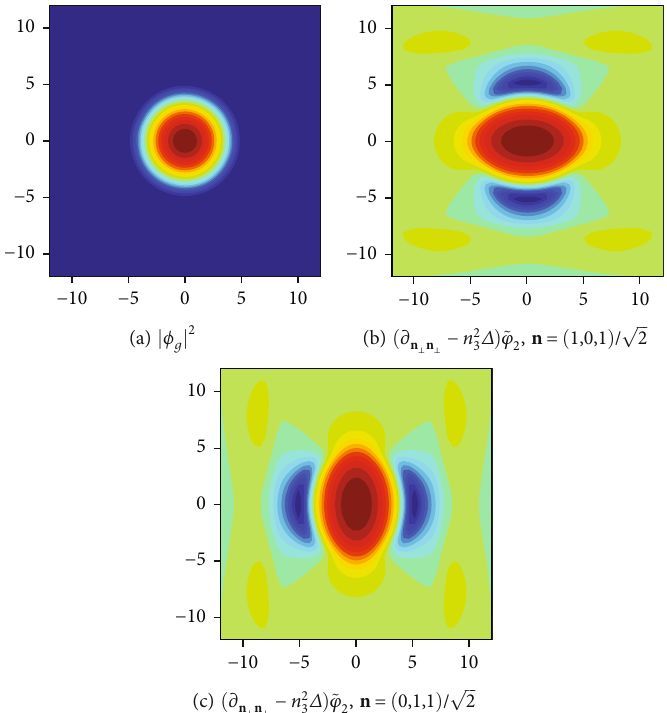
Figure 8: The contour of the density function j ϕ − n 2 Δ Þ ~ φ ð ∂ corresponding to ϕ 3 2 n ⊥ n ⊥